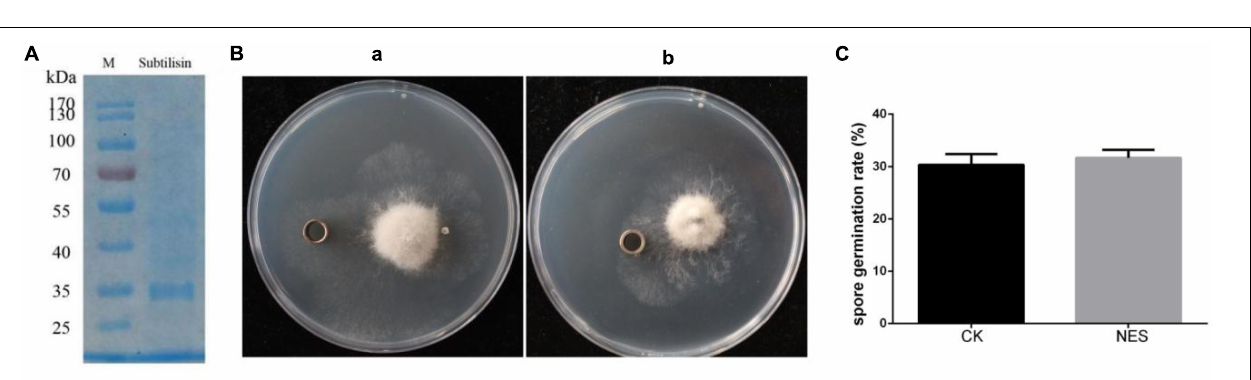
FIGURE 1 | Subtilisin transient expression improves the control effect in N. benthamiana against B. cinerea . (A) Representative phenotypes of the disease caused by B. cinerea in N. benthamiana leaves expressing pK7WG2D (a) and pK7WG2D-subtilisin (b) at 3 DAI. Photographs were taken at 3 days after inoculation with B. cinerea. Experiments were carried out with five leaves per treatment. (B) Lesion diameter of disease caused by B. cinerea in N. benthamiana leaves expressing pK7WG2D (CK) and pK7WG2D subtilisin (NES). Data presented in (B) are the means ± SD of lesion diameter of five leaves. The statistical analyses were performed using the Student’s t -test; and asterisks indicate significant differences between pK7WG2D and pK7WG2D-subtilisin treatment (** p < 0.01). (C) Protein accumulation detected by western blot using anti-flag and anti-Actin antibody in N. benthamiana leaves expressing pK7WG2D (CK) and pK7WG2D subtilisin (NES).